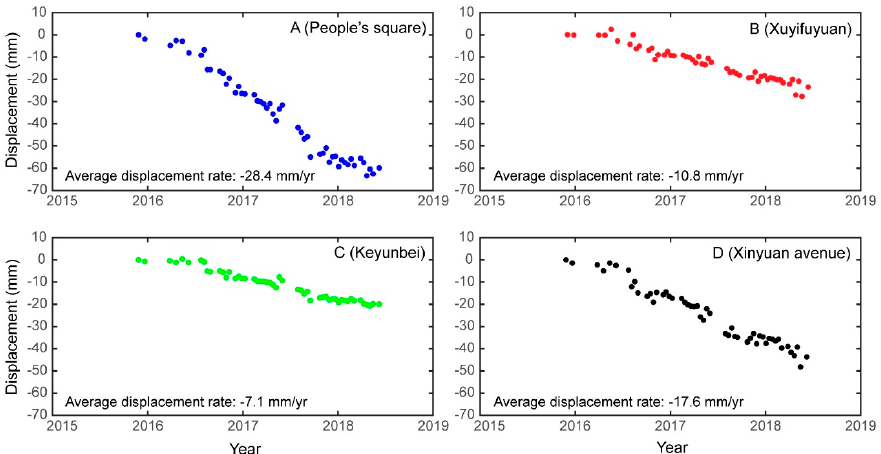
Figure 9. Displacement time series and displacement rates at points A, B, C and D shown in Figure